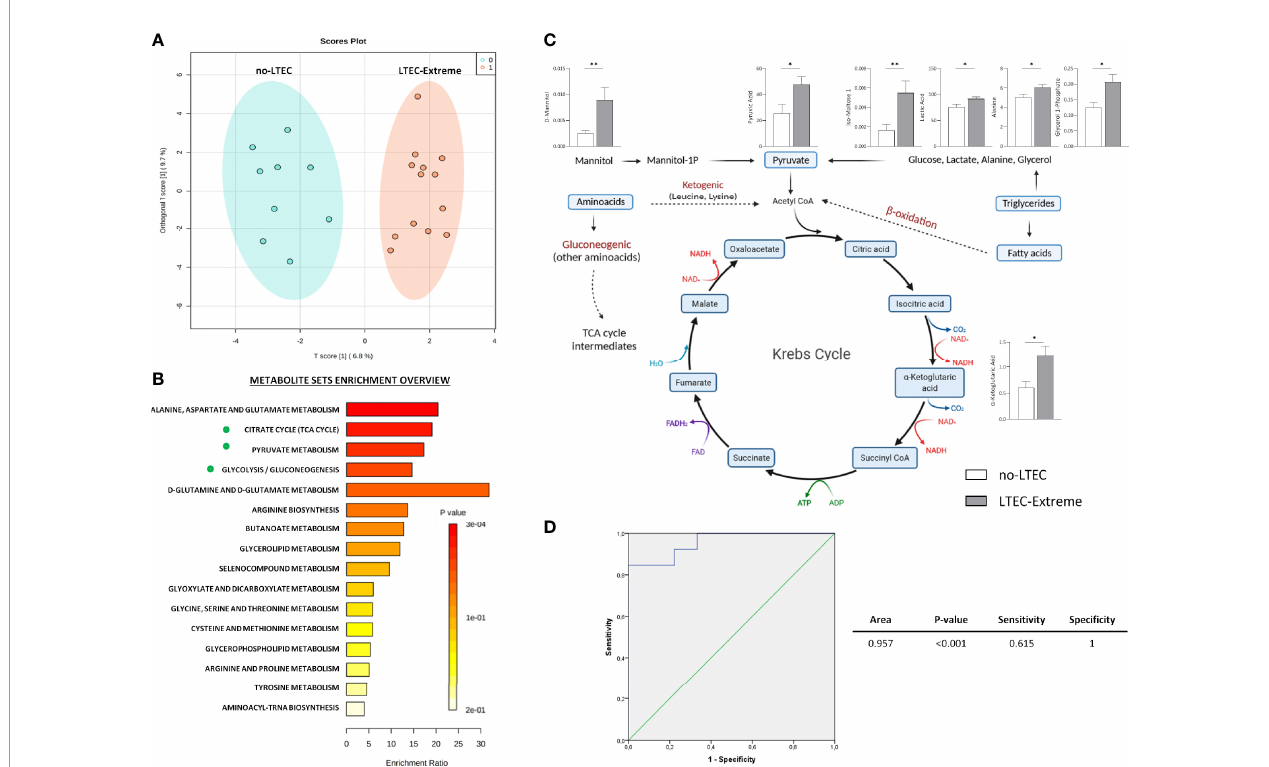
FIGURE 2 | Metabolic analysis comparing long-term elite controller (LTEC)-extreme and no-LTEC. (A) Orthogonal principal component analysis (ortho-PCA) of the 78 metabolites between LTEC-extreme and no-LTEC. (B) Metabolic enrichment pathways associated with the metabolites differentially expressed in the LTEC- extreme group [Kyoto Encyclopedia of Genes and Genomes (KEGG) database]. The x-axis indicates the impact of selected metabolites in the presented pathway, while the y-axis shows the level of enrichment of the pathway. (C) Illustration of the principal signi fi cant metabolites between LTEC-extreme and no-LTEC in the tricarboxylic acid (TCA) cycle (column bars indicating differences in relative plasma concentrations of those metabolites implicated in the Krebs cycle; white bar represents no-LTEC; gray bars represent LTEC-extreme [mean + SEM data]. *P < 0.05; **P < 0.01 (adapted from “ Kreb ’ sCycleTemplate, ” by BioRender.com (2021); retrieved from https://app.biorender.com/biorender-templates). (D) Logistic regression and receiver operator characteristic (ROC) curves elucidated the statistically signi fi cant metabolomics pro fi le from the combination of 7 statistically signi fi cant TCA cycle metabolites as main differentiators between LTEC-extreme and no-LTEC- losing [area under the curve (AUC) =